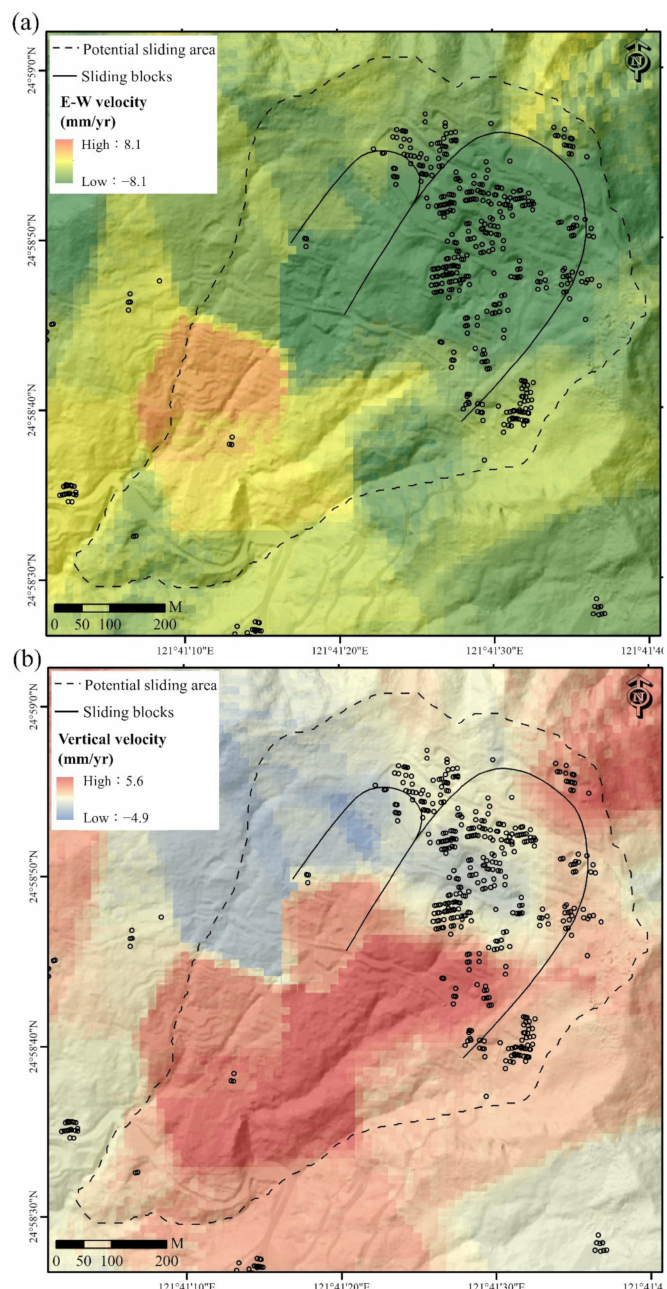
Figure 6. The E–W and vertical displacement fields were obtained from the PSInSAR results of two different satellite viewing geometries. ( a ) The surface displacement of the slope toward the west direction is clearly shown. Red indicates the surface displacement is toward the east, while green indicates the surface displacement is toward the west. ( b ) There is significant subsidence on the upper part of the slope and uplift on the toe of the sliding blocks. Red indicates subsidence of the surface, while blue indicates uplift of the surface. The background topography is shown by shaded relief imagery produced from a 2 m